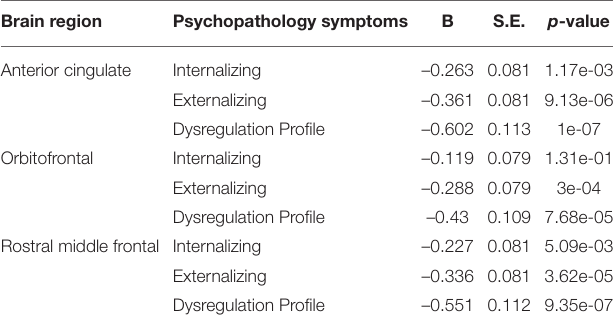
TABLE 6 | Hypothesis driven surface area model